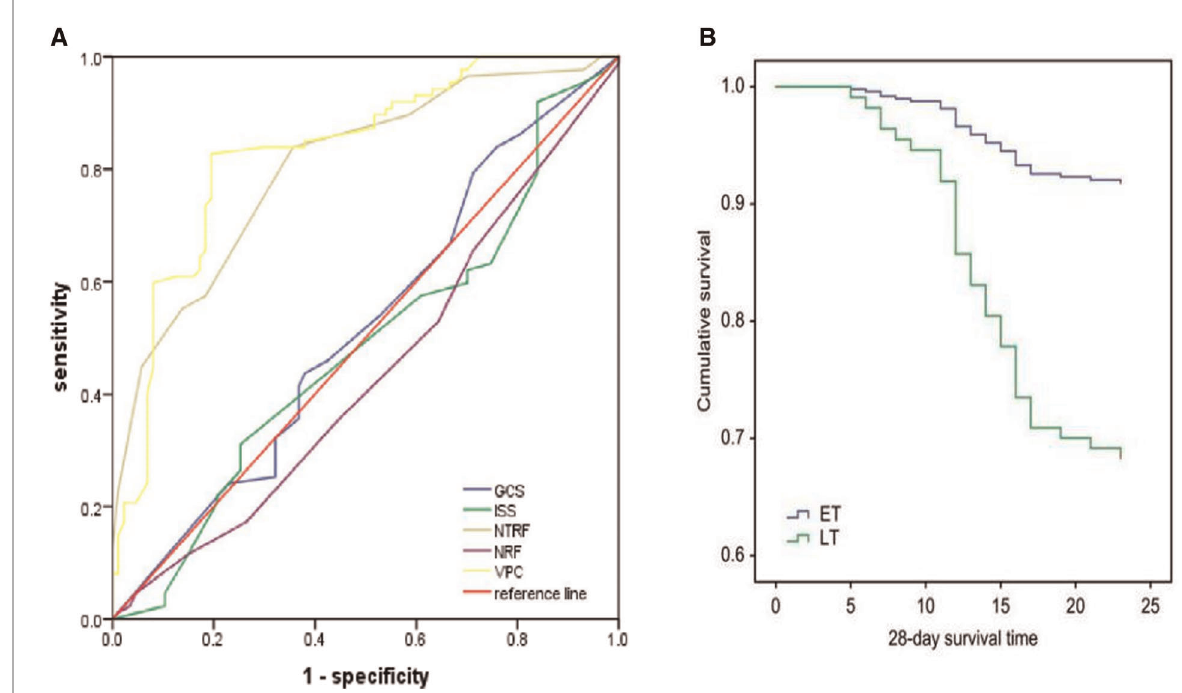
FIGURE 3 Results of the ROC curve analysis ( A ). Kaplan – Meier survival analysis based on the 28-day mortality ( B ). GCS, Glasgow coma score; ISS, injury severity score; ARDS, acute respiratory distress syndrome; VPC, volume of pulmonary contusion; NRF, number of rib fractures; NTRF, number of total rib fractures. ET, early tracheostomy; LT, late